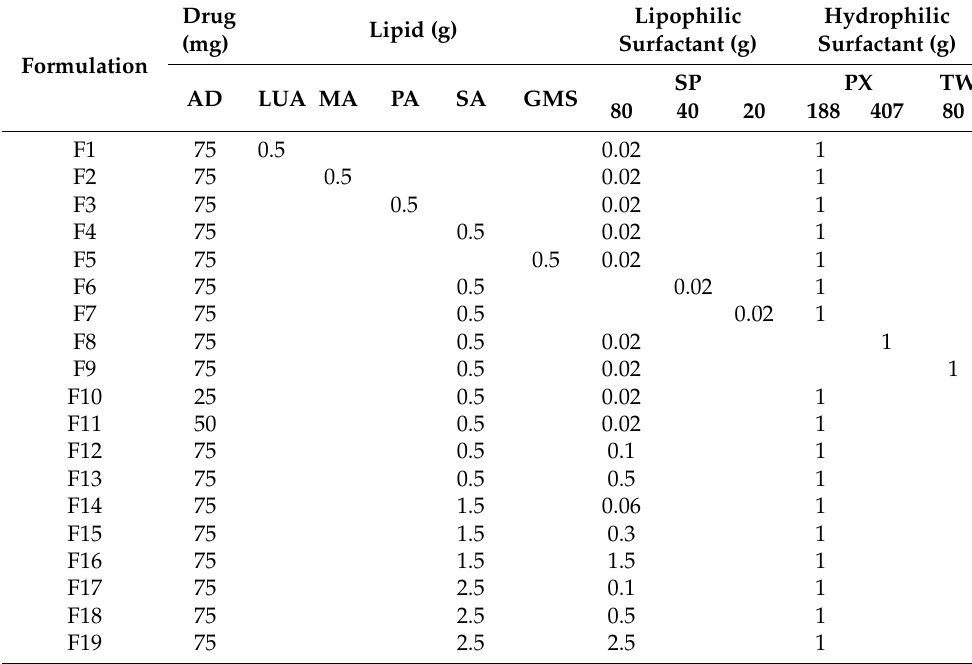
Table 1. Composition of adenosine (AD)-loaded solid lipid nanoparticles.